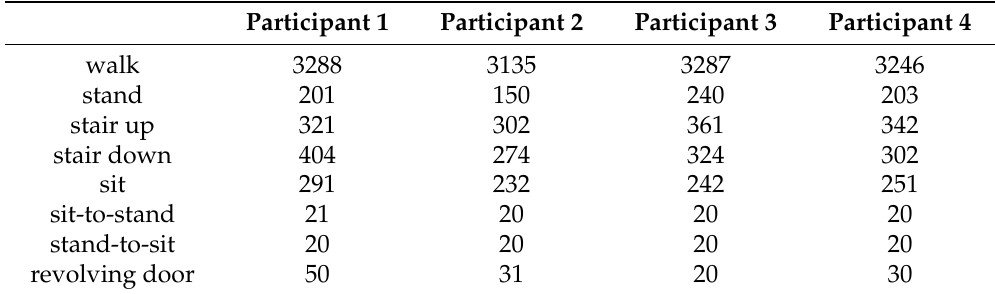
Table 2. Amount of test data per participant. This table shows the total number of samples per participant across steps 1, 2, 3, 5, and 6 of the test data collection. The sampling frequency was approximately 10 Hz (i.e., 10 samples per second). For each participant, we present the number of samples of each activity type. The activity types observed in the test data collection included walking (“walk”), standing (“stand”), ascending stairs (“stair up”), descending stairs (“stair down”), sitting (“sit”), the sit-to-stand transition (“sit-to-stand”), the stand-to-sit transition (“stand-to-sit”), and going through a revolving door (“revolving door”). The “walk” activity includes slow-, normal-, and fast-paced